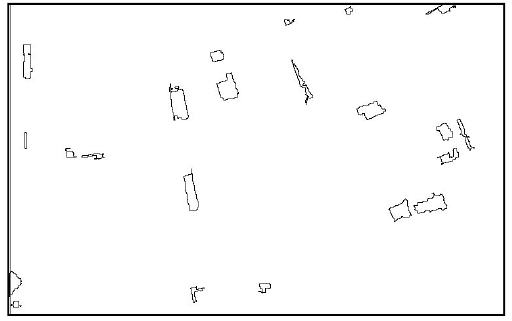
Figure17. Temporary architecture extraction